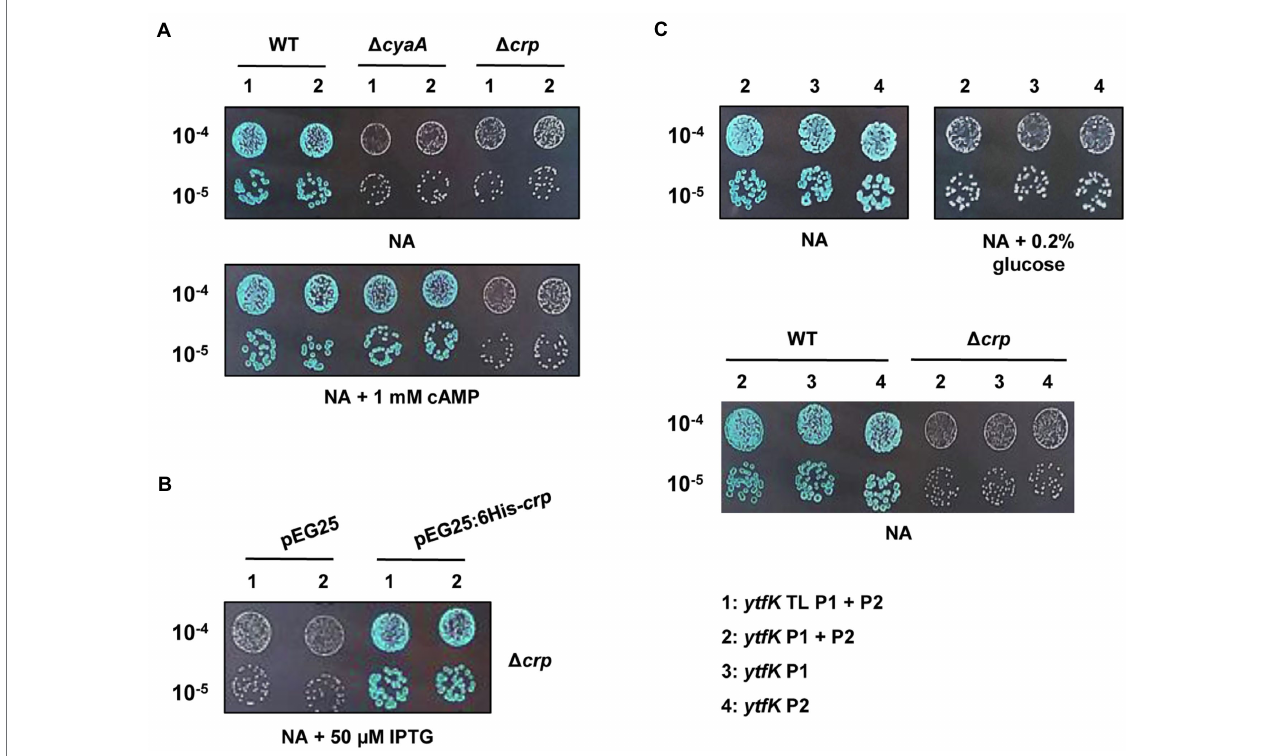
FIGURE 2 | ytfK expression is controlled by cAMP level and requires the presence of the master regulator CRP. (A) Stationary-phase cultures of WT (TB28), Δ cyaA or Δ crp cells expressing translational (1: ytfK TL P1 + P2) or transcriptional (2: ytfK P1+ P2) lacZ fusions were serially diluted and 5 µl of 10 −4 and 10 −5 dilutions were spotted on X-gal NA plates supplemented or not with 1 mM cAMP. (B) Stationary-phase cultures of TB28 Δ crp cells harboring pEG25 or pEG25:6His- crp plasmids and expressing translational (1: ytfK TL P1 + P2) or transcriptional (2: ytfK P1+ P2) fusions were serially diluted and spotted on X-gal NA plates supplemented with 50 μ M IPTG. (C) Stationary-phase cultures of WT (TB28) or Δ crp cells expressing transcriptional (2: ytfK P1+ P2; 3: ytfK + P1 or 4: ytfK + P2) lacZ fusions were serially diluted and spotted on X-gal NA plates supplemented or not with 0.2% of glucose. Results are representative of three independent